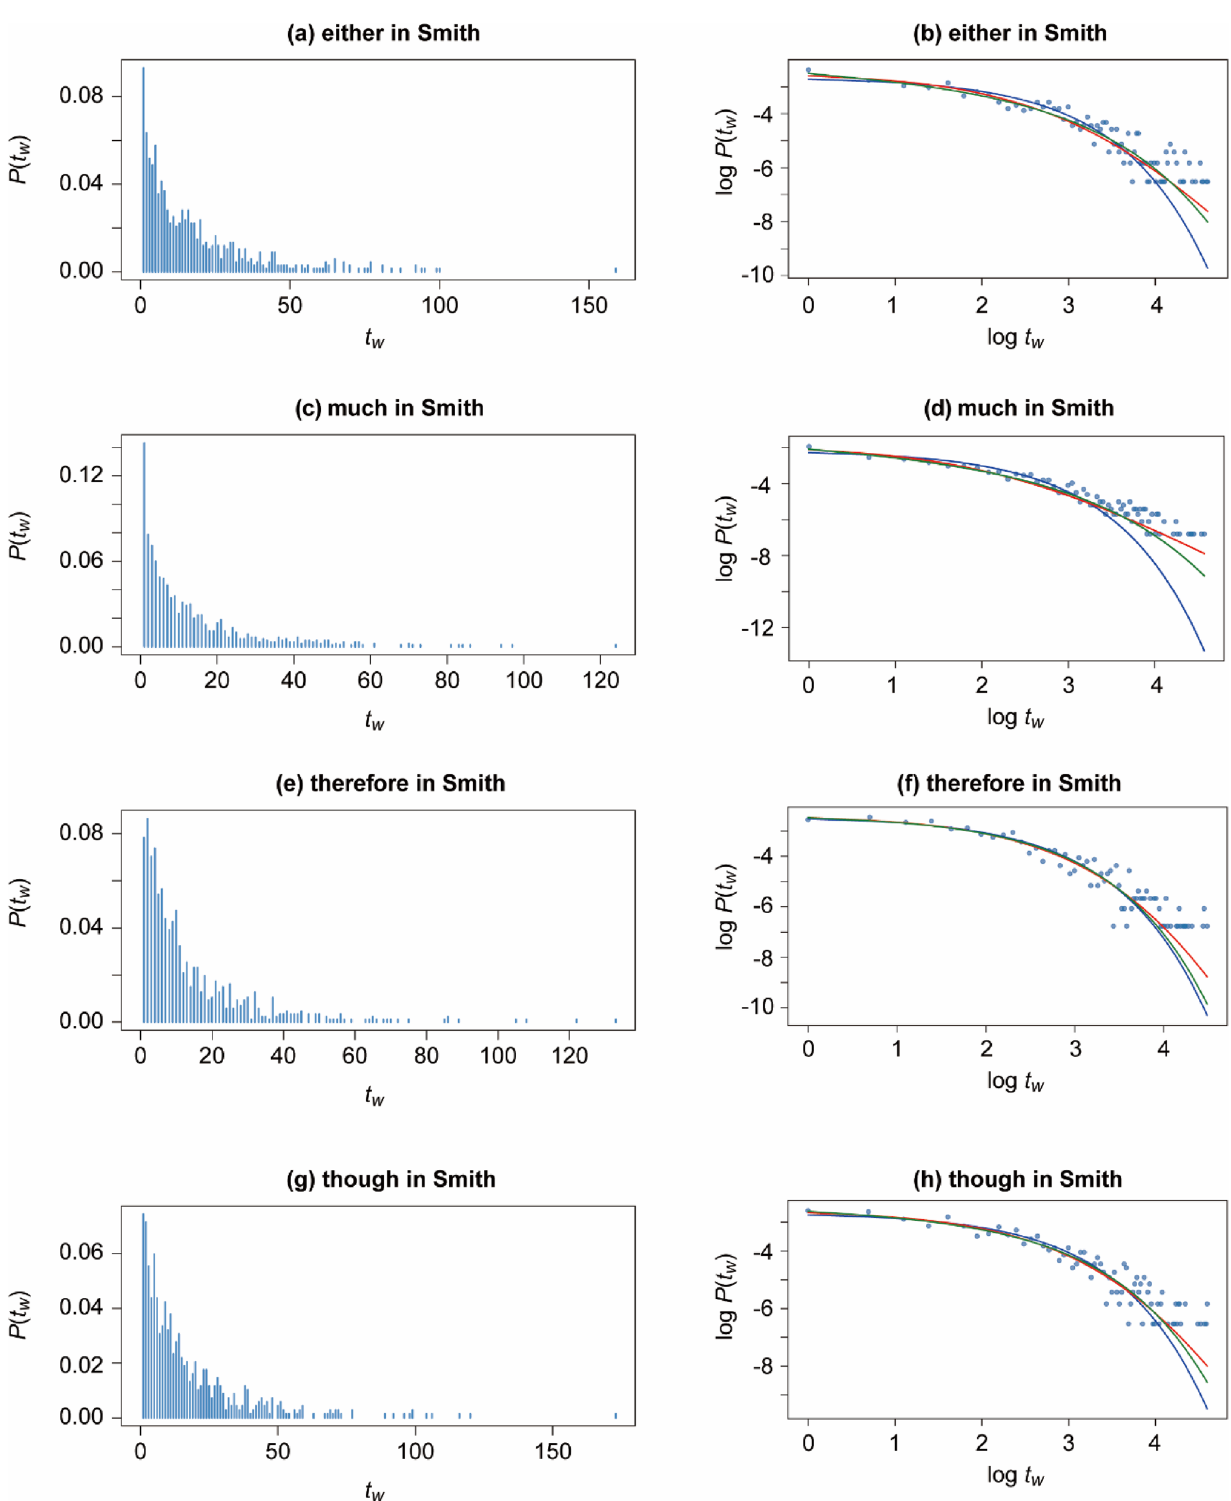
curves show optimized fitted results using the q-exponential, the Weibull and the exponential distributions, respectively. Results for the words “either” (( a ) and ( b )), “much” (( c ) and ( d )), “therefore” (( e ) and ( f )), and “though” (( g ) and ( h )), which are typical Type-II words picked from the Smith